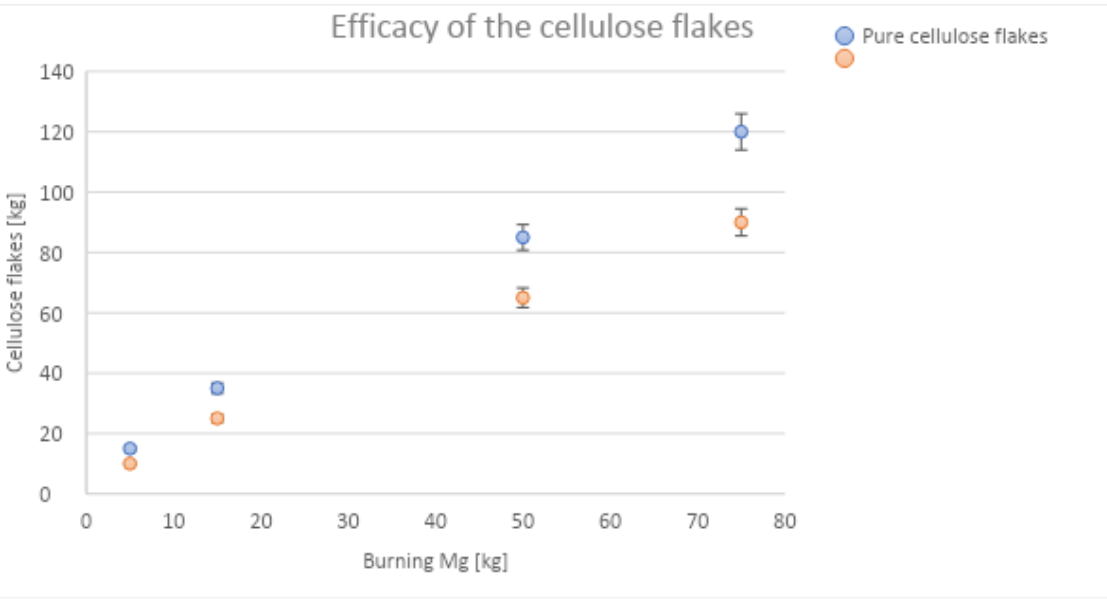
Figure 9. Approx. amount of cellulose flakes containing 30% salts to extinguish a fully developed magnesium fire.